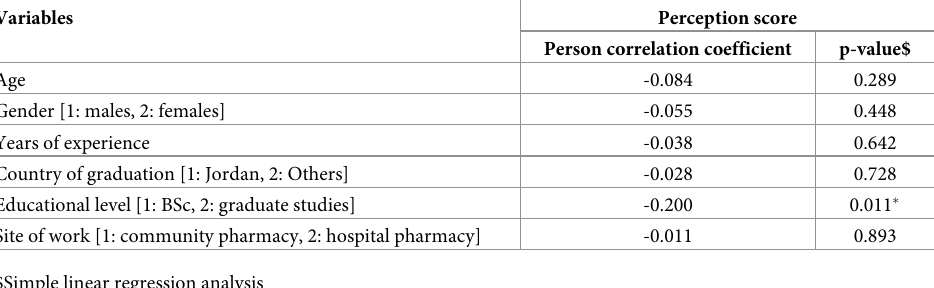
Table 4. Simple linear regression analysis for factors affecting pharmacists’ perception scores toward patient use of Internet-based medication